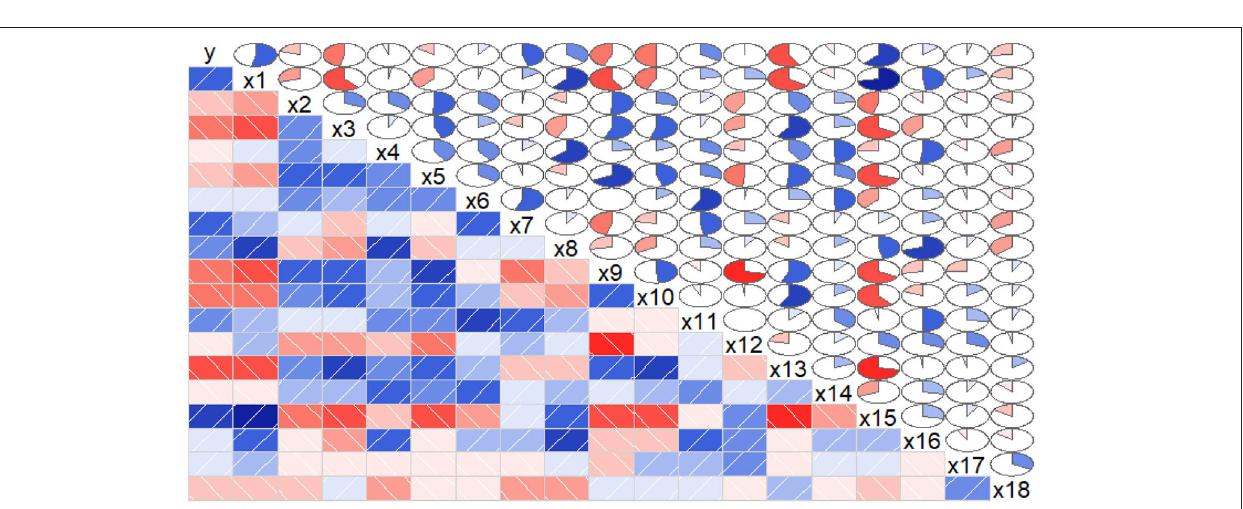
physiological/biochemical indicator, but by a combination of some effective physiological/biochemical indicators ( Figures 3 , 4 ). Therefore, it was necessary to systematically analyze the relationship between the physiological/biochemical indicators and the